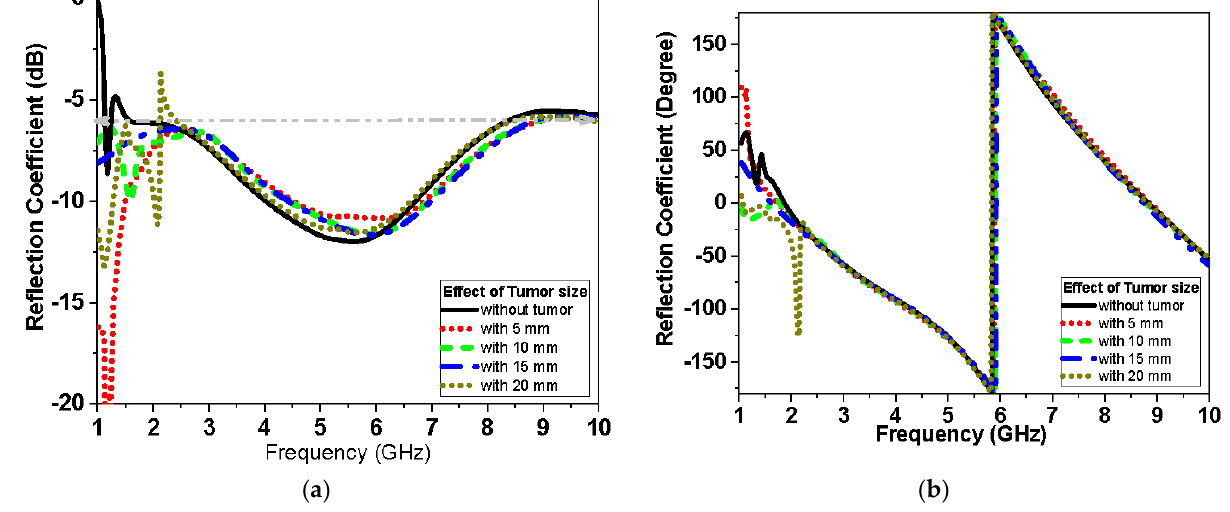
Figure 15. Simulated|S 11 |of proposed monopole flexible Roger antenna with tumor (first scenario as shown in Figure 14a) at different sizes of tumor: ( a ) magnitude in dB and ( b ) phase in degrees.